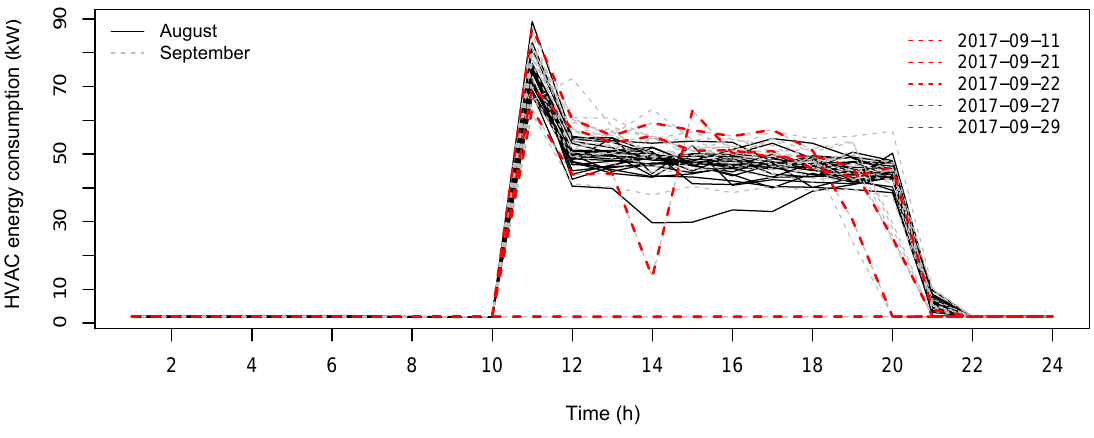
Figure 3. Daily curves of energy consumption in HVAC facilities of the Panama City’s store. The natural control limits are estimated from the curves belonging to the calibration sample, which have been shown which (Phase